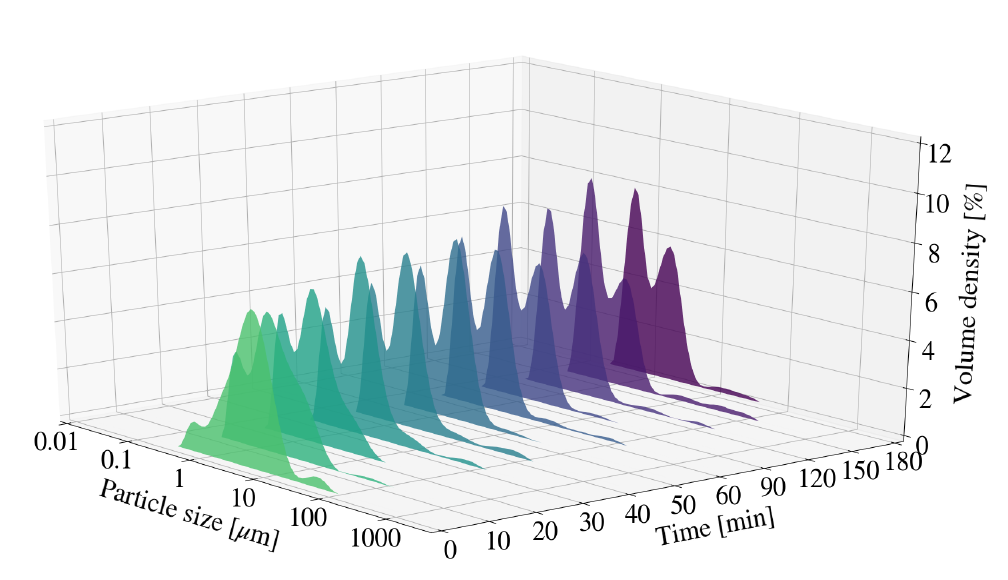
Figure 5. Particle size distribution for Mg-Al LDH samples synthesised at a cooling water inlet temperature of 50 °C, with a change in residence time (S12).